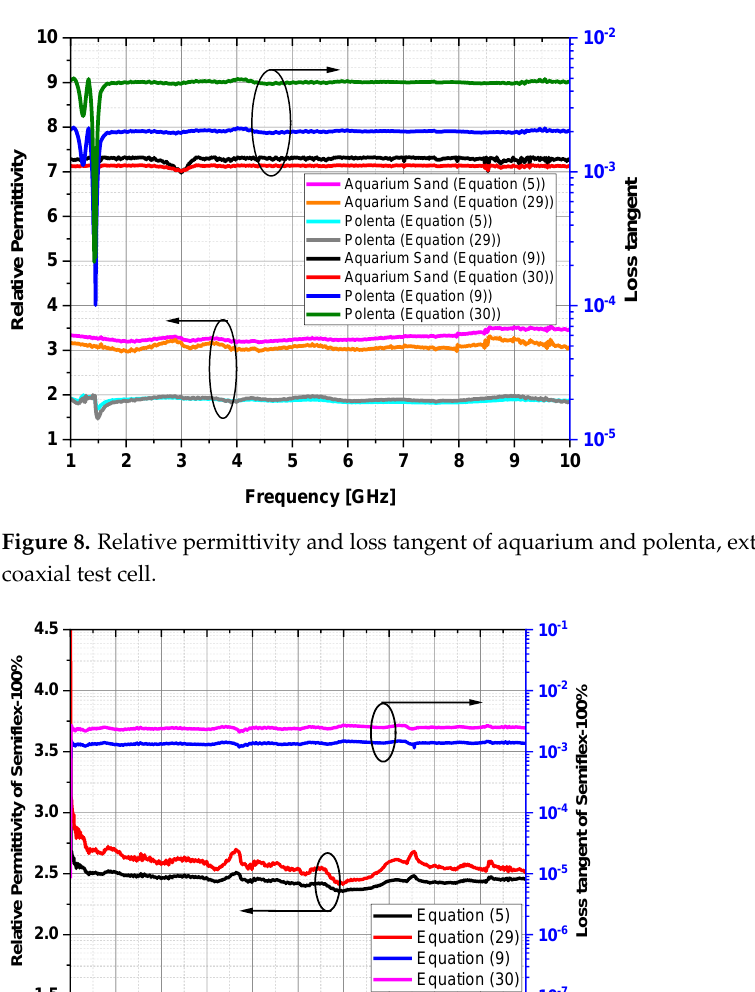
Figure 10. Relative permittivity and loss tangent of the PLA measured with the circular coaxial fixture. We sketched results from the proposed approach and compared them to those from the eigenvalues principle to highlight its advantages and drawbacks. It can be seen that all relative permittivity and loss tangent plots had a similar trend. Similarly, differences in the results were not significant. This indicates that both Equations (52) and (29) are almost equal, but Equation (29) shows improved behavior. The slight difference is the use of the characteristic impedance (which does not depend on the length), which conceptually keeps the same value in the entire frequency range. At the same time, the loss tangent expressions given in Equations (9) and (30) depend on a factor that is not necessarily equal to a fixed number, as shown in Equation (9). The loss tangent, computed from Equation (9), clearly depends on